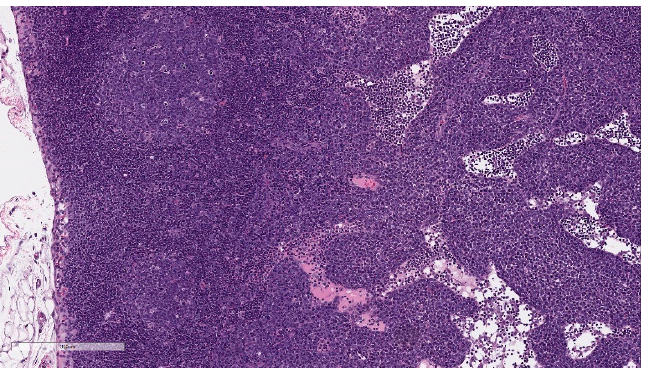
Figure 8. Histopathologic features of draining lymph node at the end of the dosing phase. Lymph node sections of BNT162b2 (V9) vaccinated animal showing prominent germinal centers (GC) and inflammatory cells (predominately plasma cells) expanding sinuses (inset). Data are scanned from Study 2.